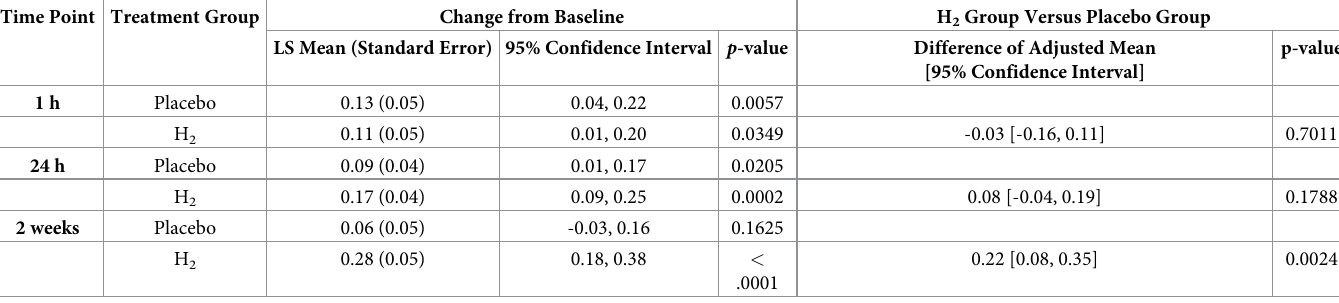
p-value [95% Confidence Interval]